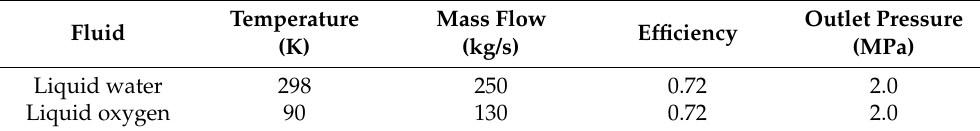
Table 3. Working condition data of liquid water and liquid oxygen.